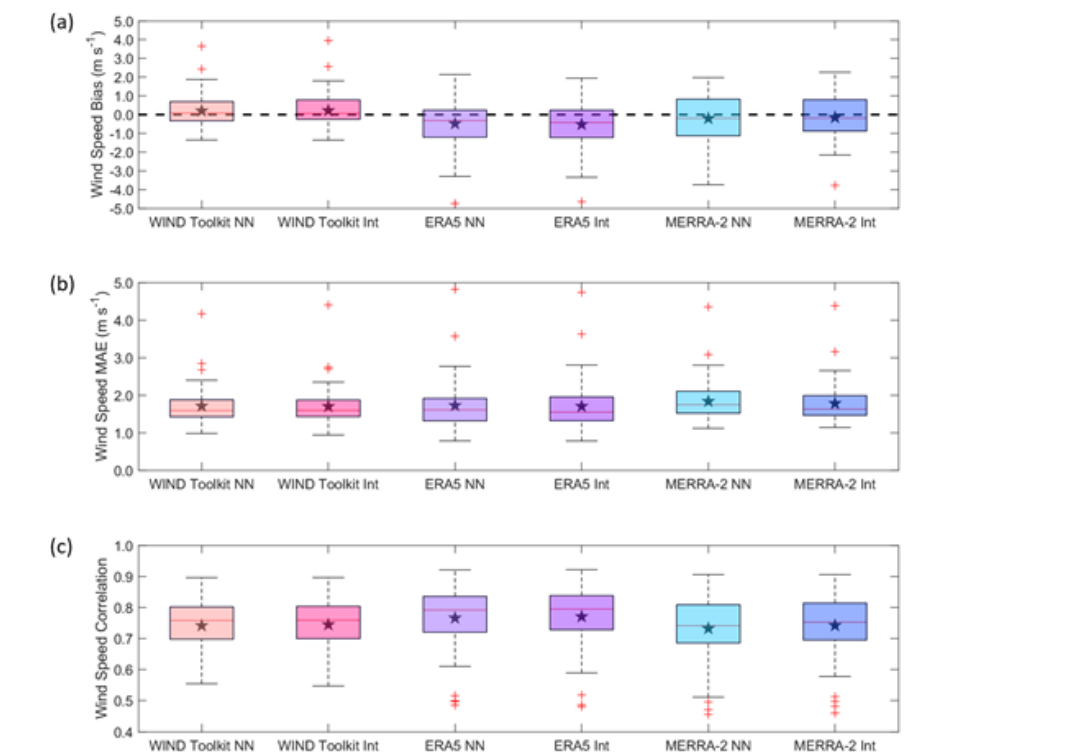
Figure 3. Wind speed (a) bias, (b) MAE, and (c) correlation across 62 sites as produced by WIND Toolkit, ERA5, and MERRA-2 using the nearest-neighbor (NN) and distance-weighted interpolation (Int) techniques. The median error metrics are indicated with the red lines; the 25th and 75th percentiles form the blue boxed range; the minimum and maximum error metrics, excluding outliers, are in black; and outliers are indicated with red plus signs. The mean error metrics are represented with black